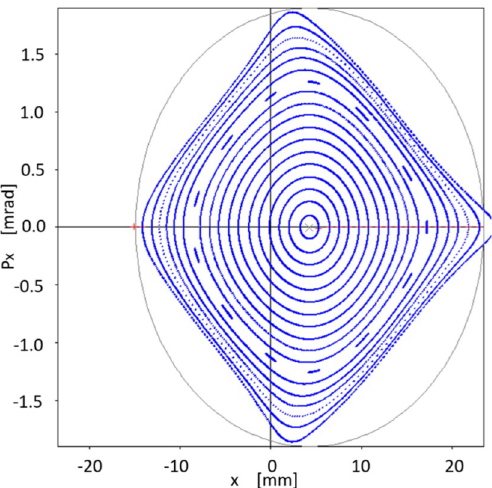
Figure 16. Structure of phase space ( x , p x ) for δ = 2% when various initial conditions are used for particle tracking simulation in OPA, using the set of sextupoles { S 2 } .